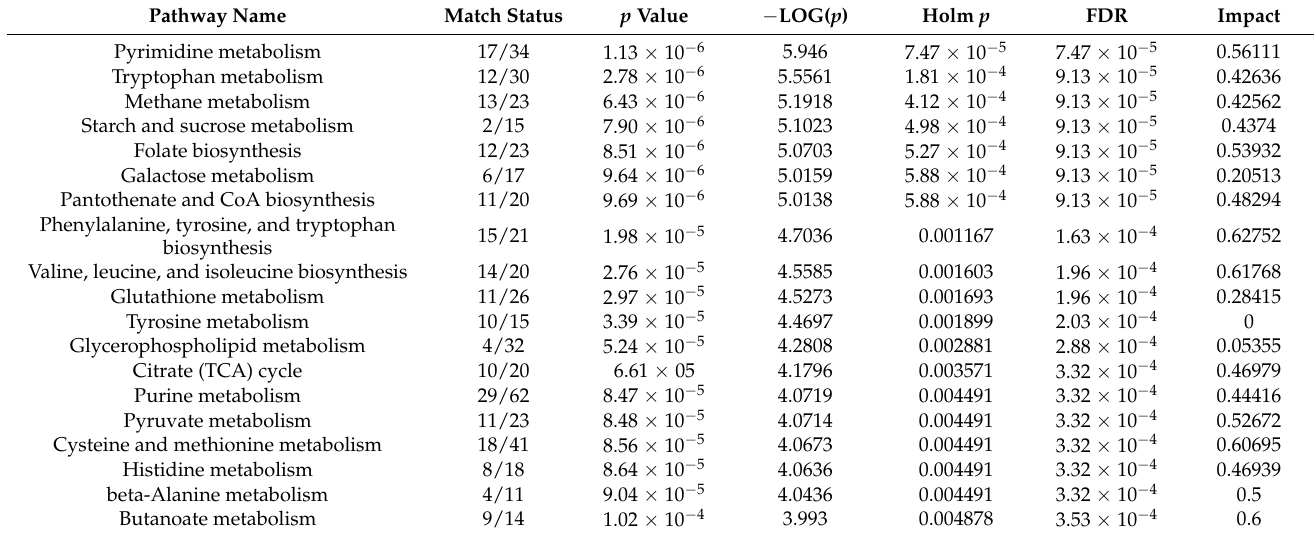
Table 3. Pathways overexpressed in the apical part compared to the middle